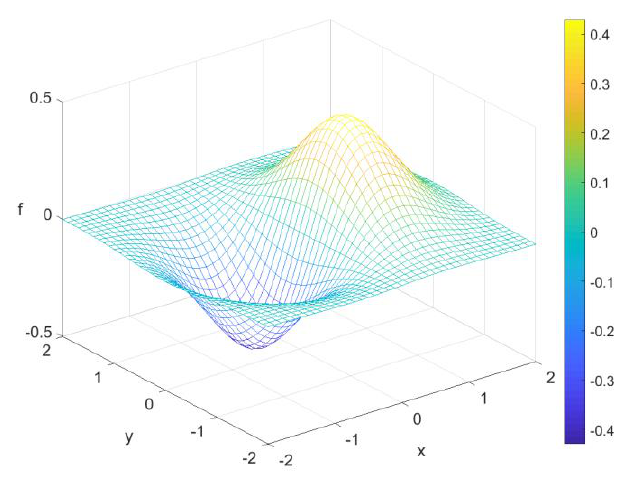
Figure 4. Original function